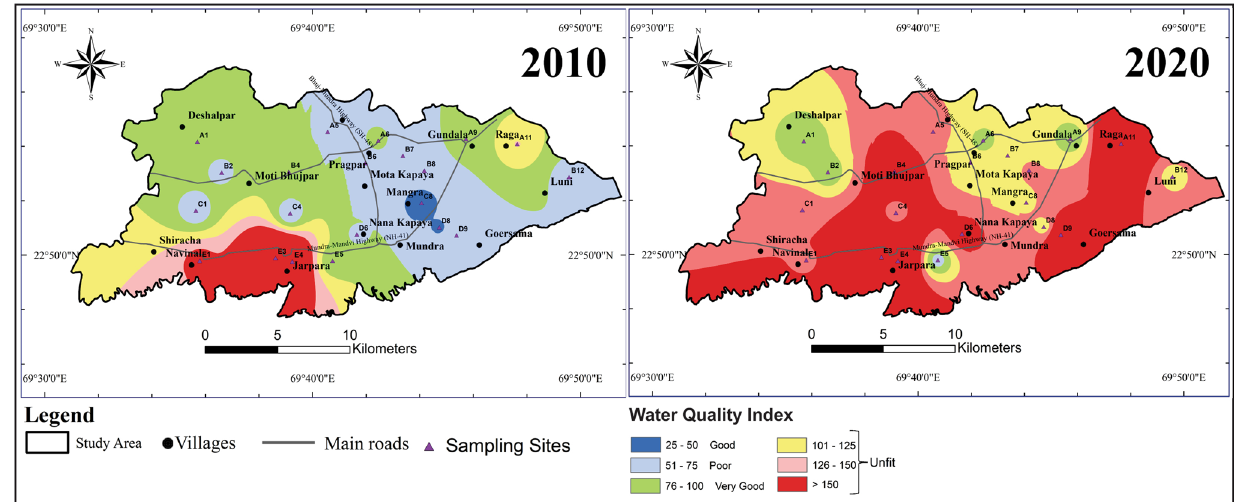
Fig. 5 Water quality index (WQI) maps for the year 2010 and 2020